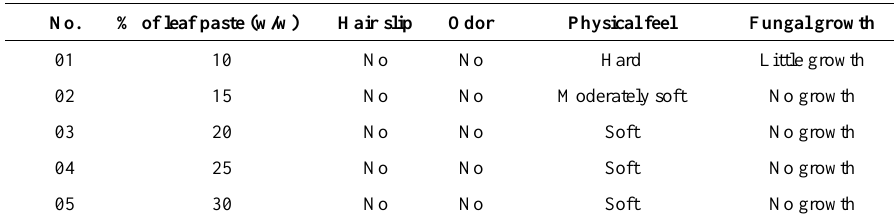
Table 1. Leaf paste optimization in this study (14